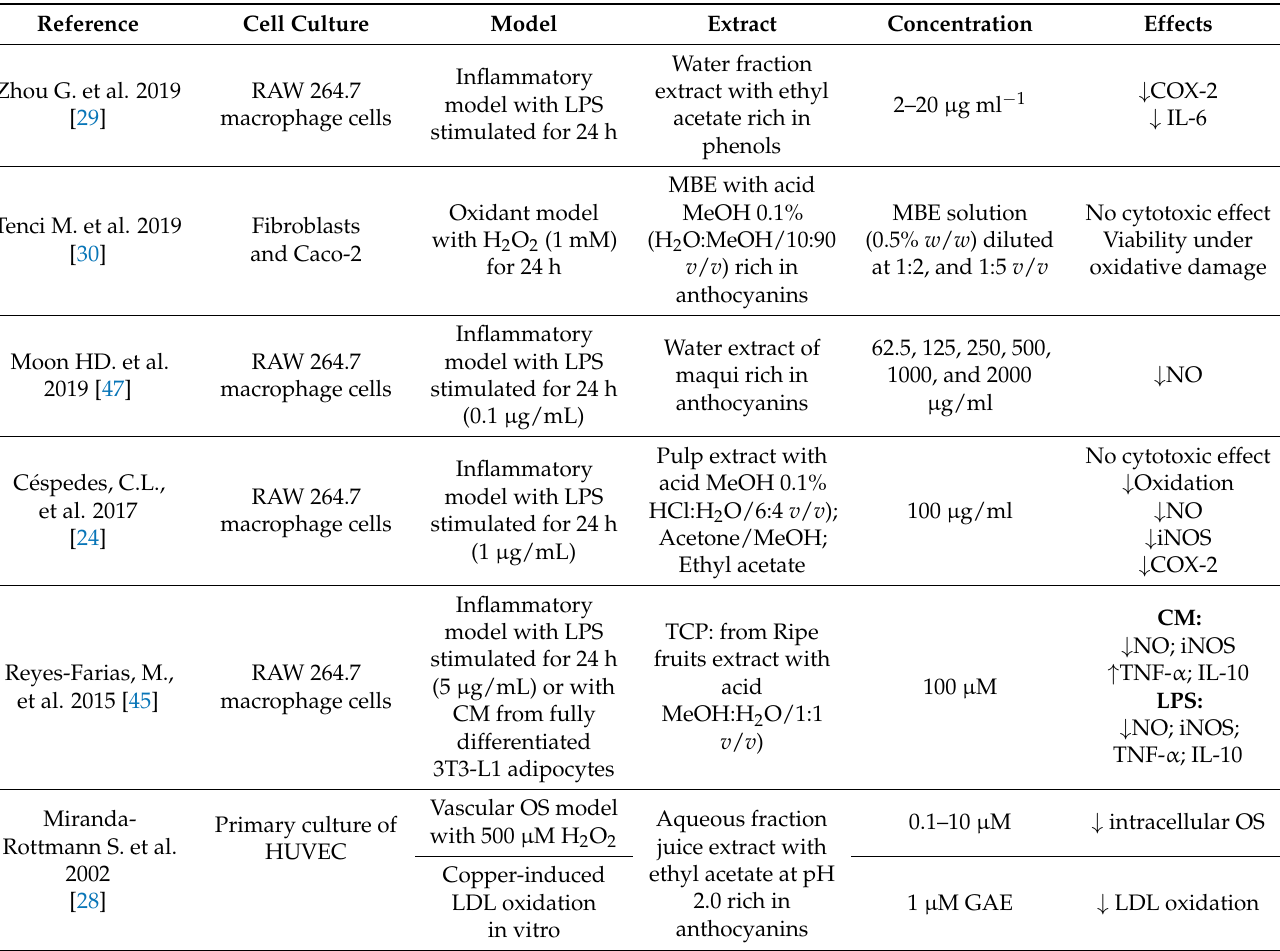
Table 3. Anti-inflammatory and antioxidant effect of maqui berry extract described on cell cultures.